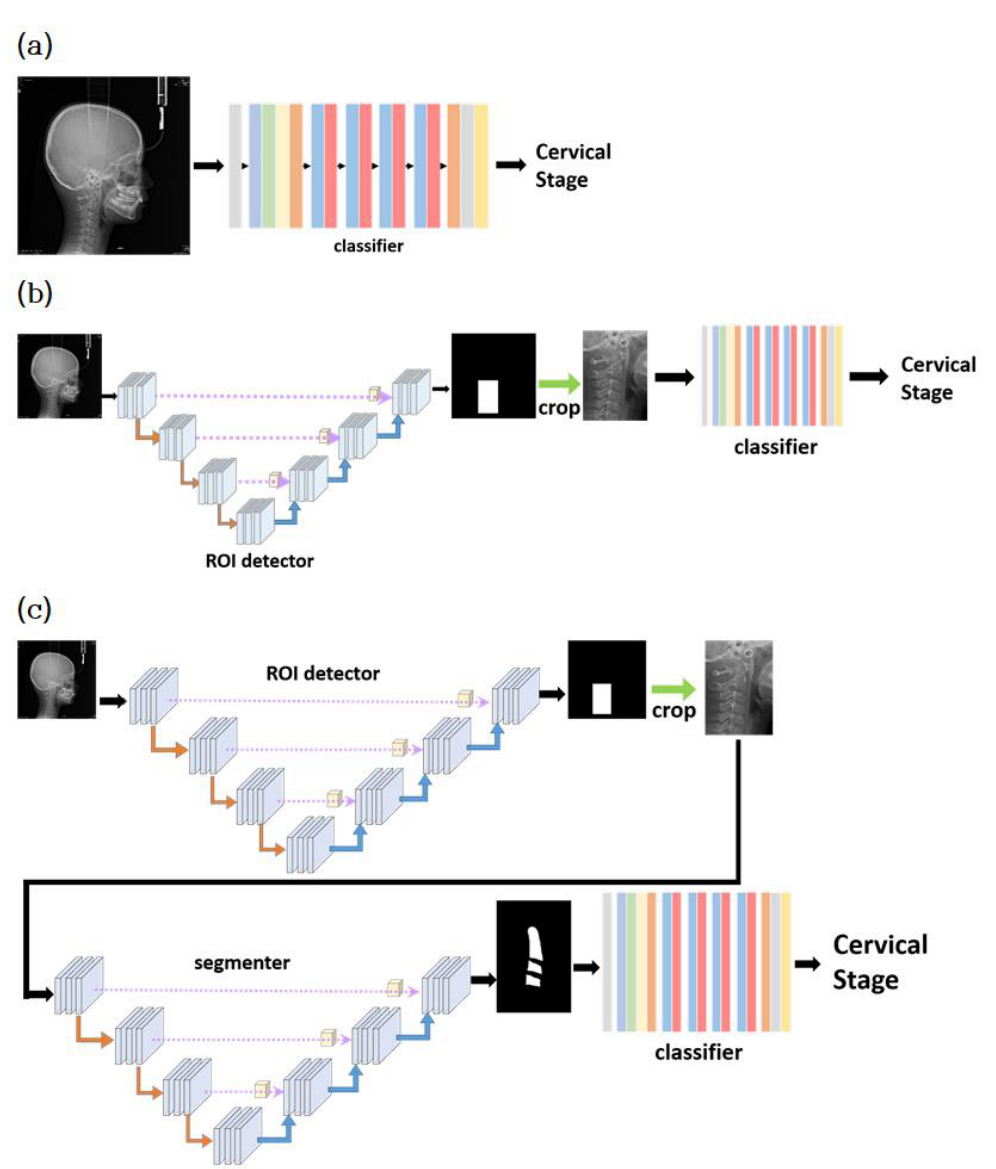
Figure 4. Architecture of three models: ( a ) model_1, ( b ) model_2, and ( c ) model_3.